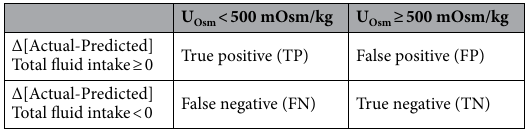
Table 1. Evaluation of the algorithm